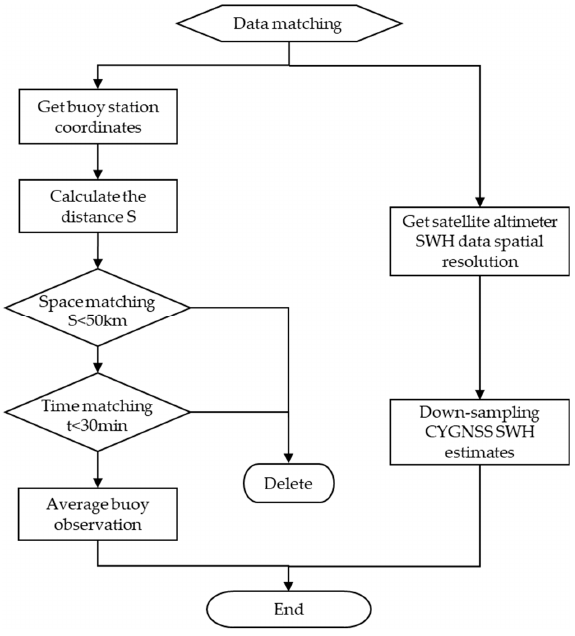
Figure 5. Matching process.